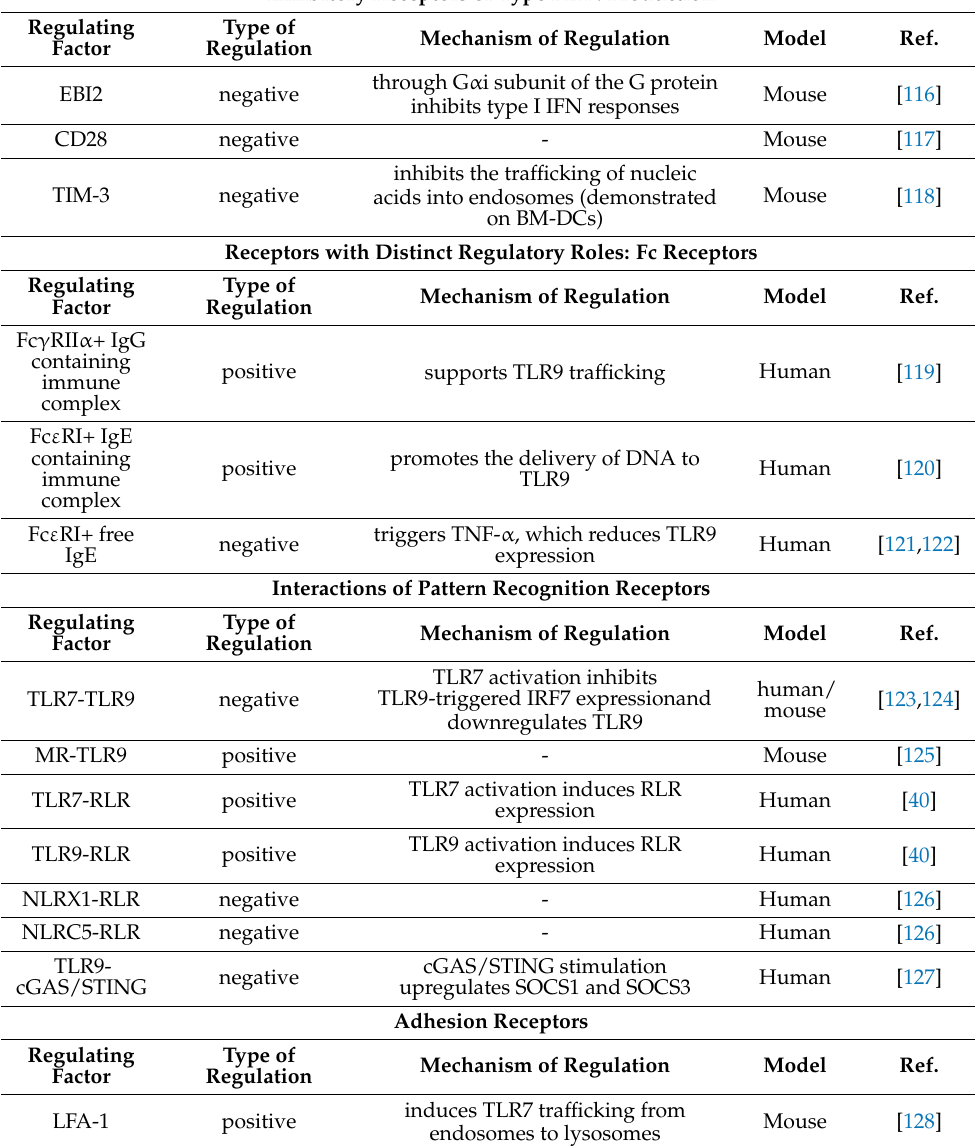
Table 2. Cont. Inhibitory Receptors of Type I IFN